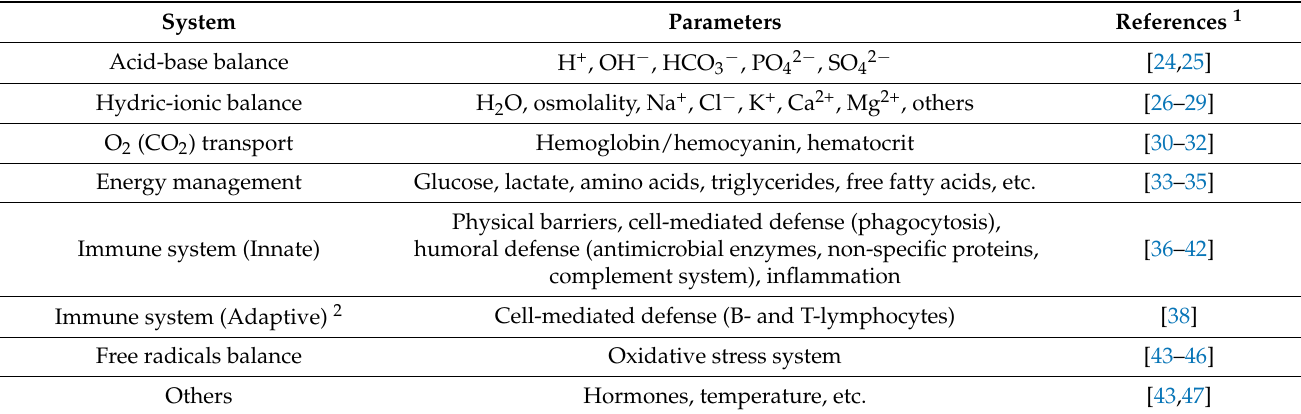
Table 1. Main physiological parameters of aquatic animals’ homeostasis. It should be noted that certain differences exist depending on the